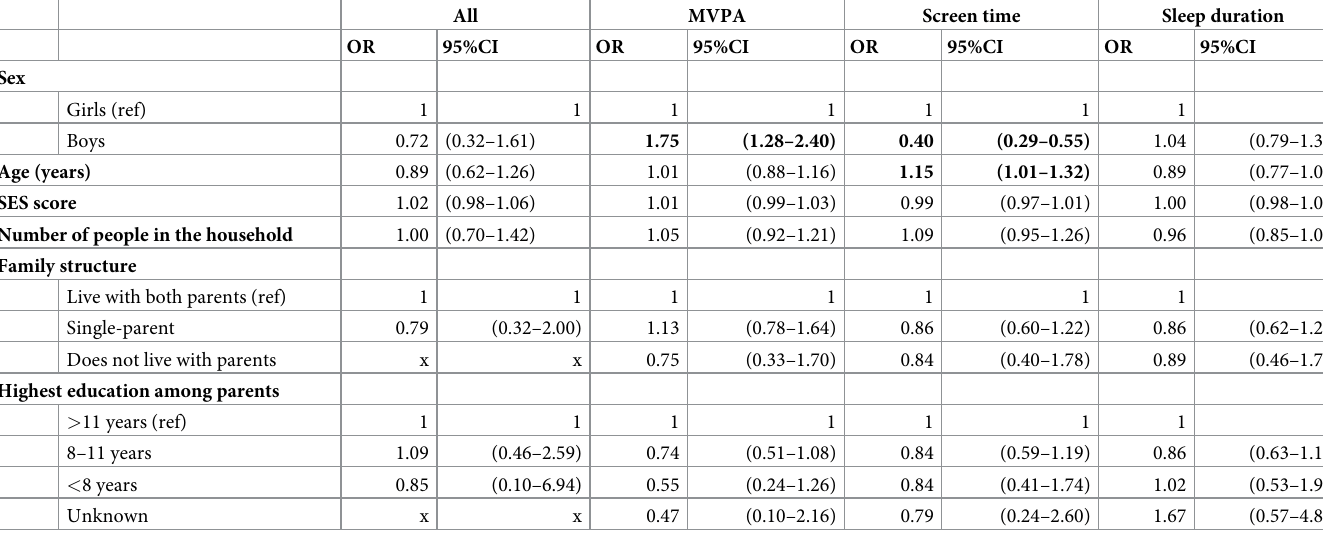
Table 3. Sociodemographic correlates of meeting each and all of the 24-hour movement behavior guidelines using self-reported data (n = 837 adolescents).